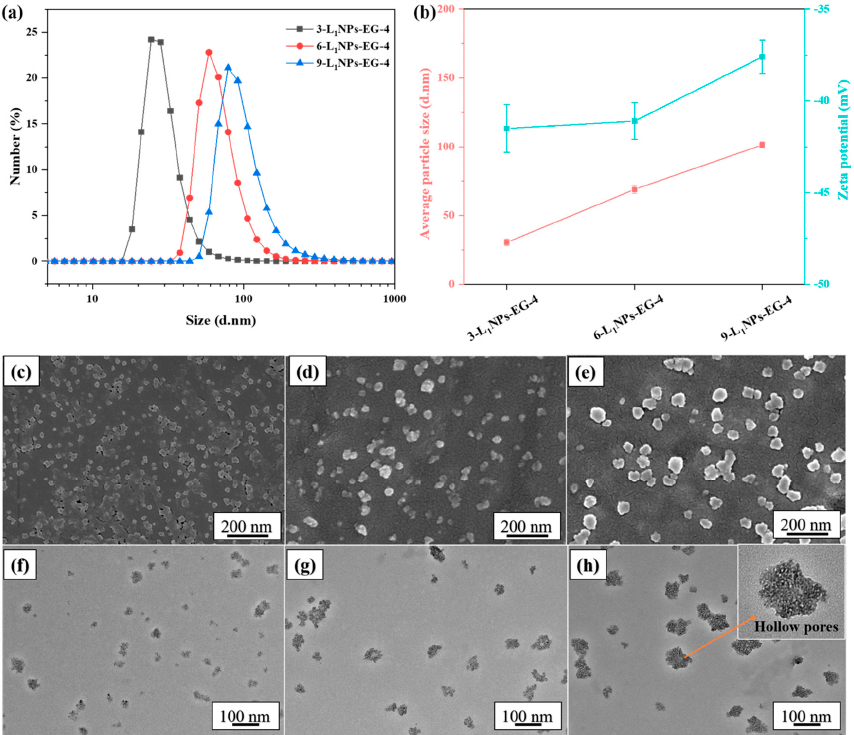
Molecules 2021 , 26 , x FOR PEER REVIEW Figure 4. ( a ) Particle size distribution, ( b ) average size and zeta-potential, ( c – e ) SEM and ( f – h ) TEM images of the LNPs obtained from different pre-dropping concentrations. ( c , f ) 3-L 1 NPs-EG-4, ( d , g ) 6-L 1 NPs-EG-4, ( e , h ) 9-L 1 NPs-EG-4.